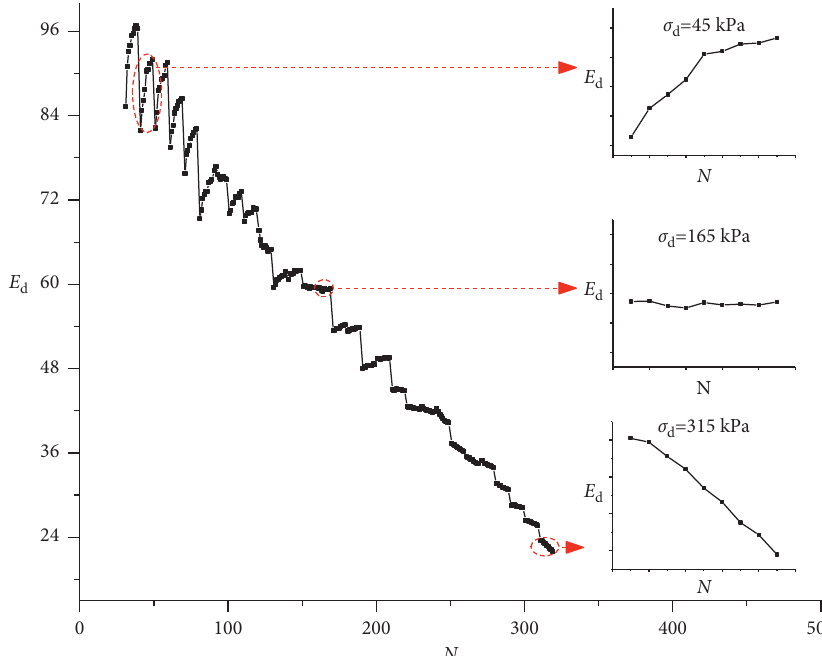
Figure 10: Dynamic elastic modulus versus cycle number curves under different dynamic stress amplitudes.